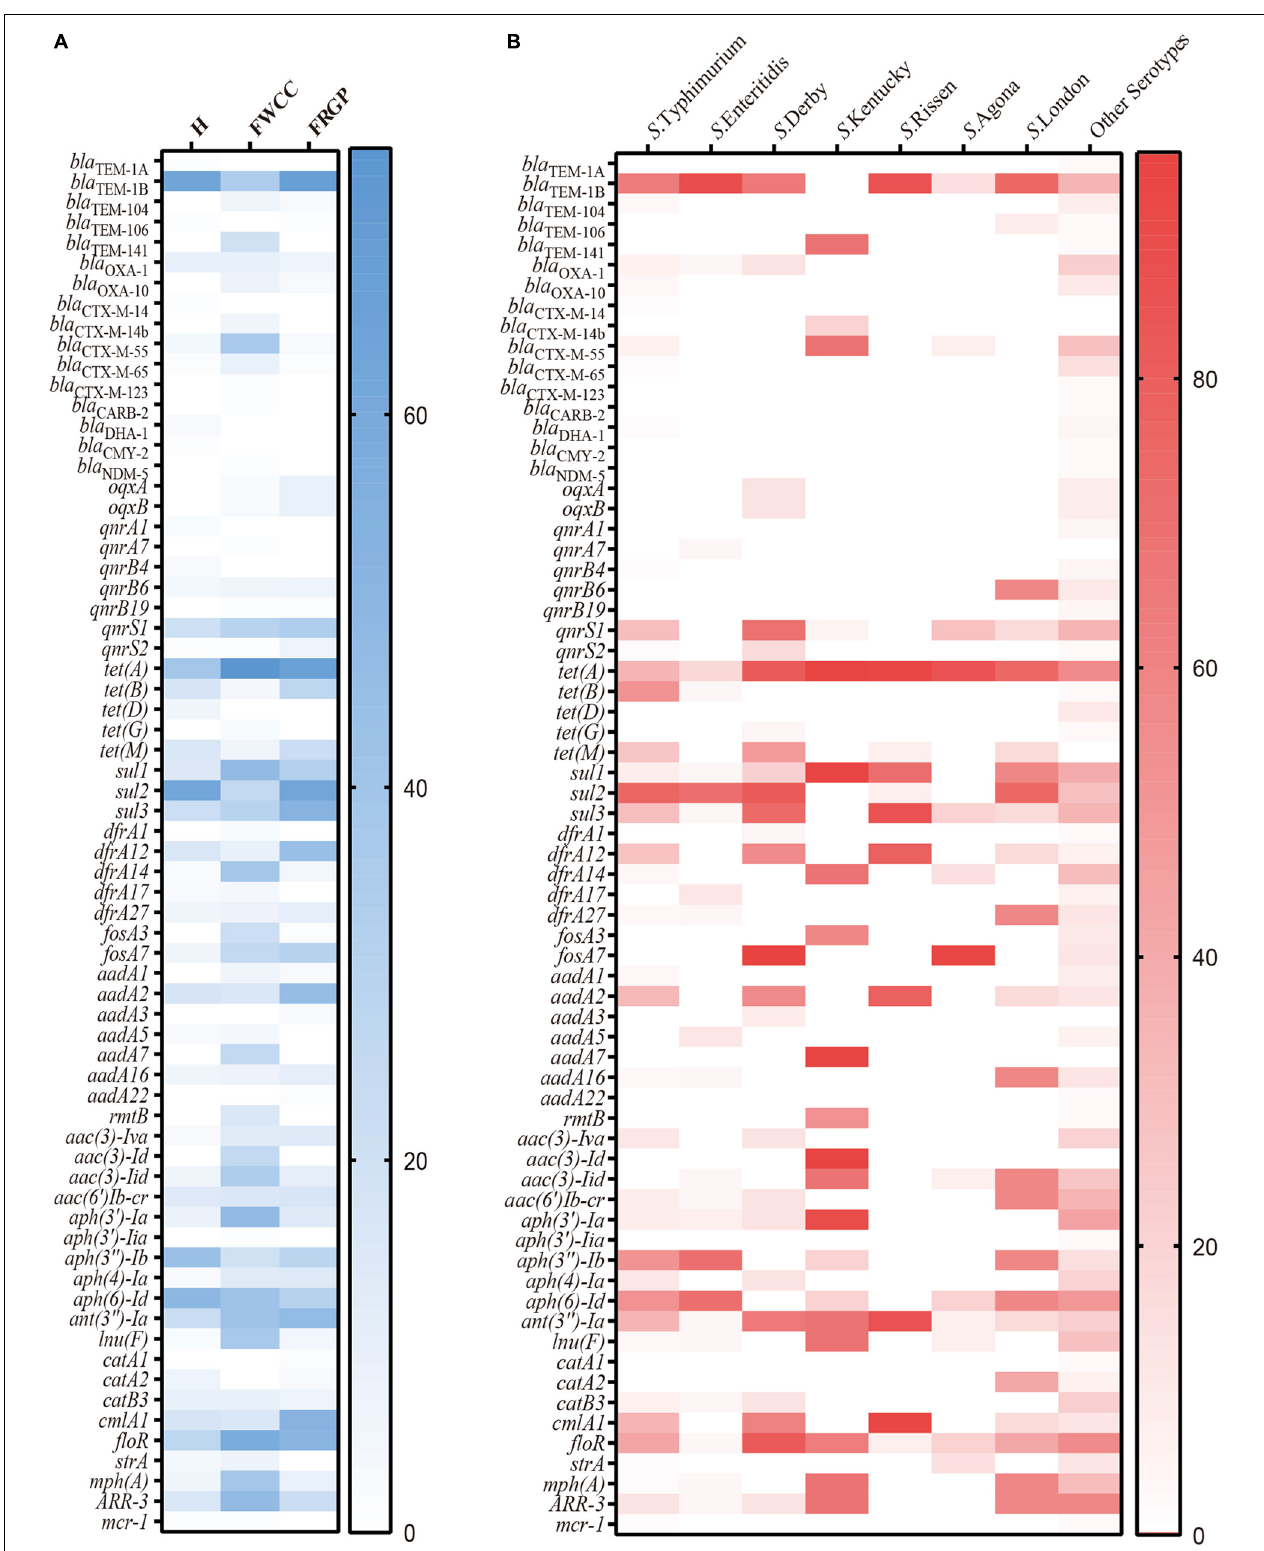
FIGURE 4 | Heatmap of antimicrobial resistance genes according to sampling sources: (A) serotypes; (B) H, human; FWCC, frozen whole chicken carcasses; FGRP, frozen raw ground pork.